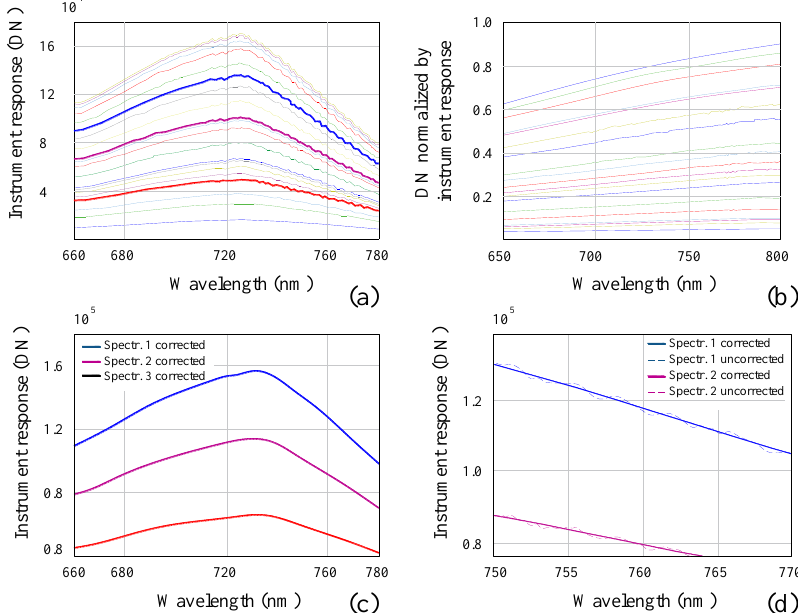
Figure 2. ( a ) Uncorrected spectral measurements of 20 light intensity levels of the tungsten halogen calibrated light and ( b ) their respective ‘by-reference’ corrected wavelengths. ( c ) Presents the ‘by curve-fitting and residual interpolation’ corrected spectra of the three curves highlighted in ( a ) with the same colors, and the detailed example of corrected vs. uncorrected instrument response is shown in ( d ) [34].